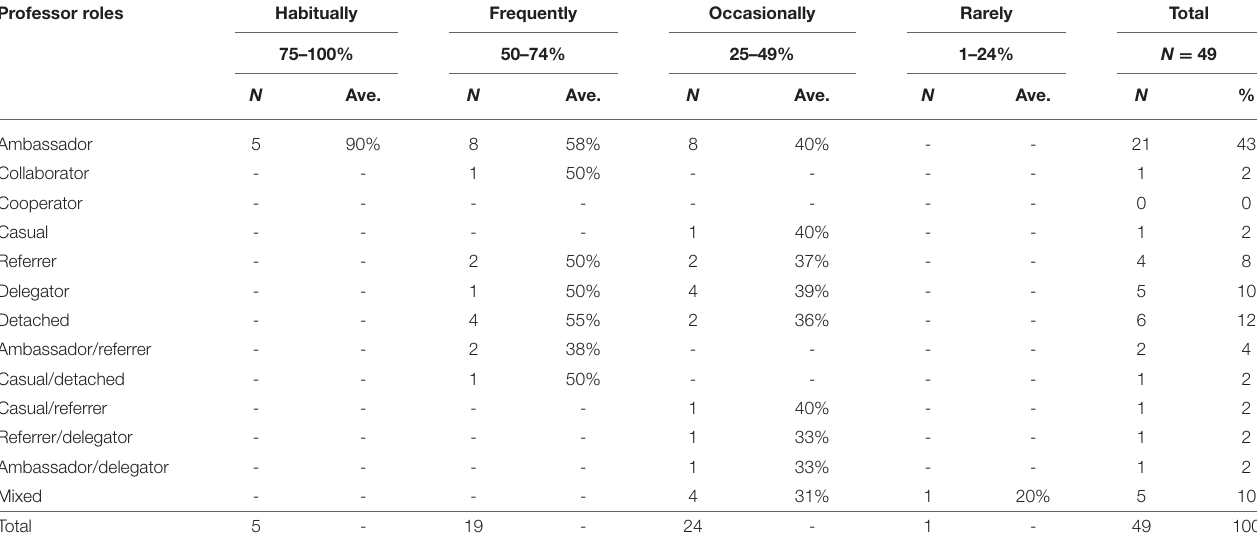
TABLE 4 | Frequency of roles adopted by professors to help students develop academic integrity. Professor roles